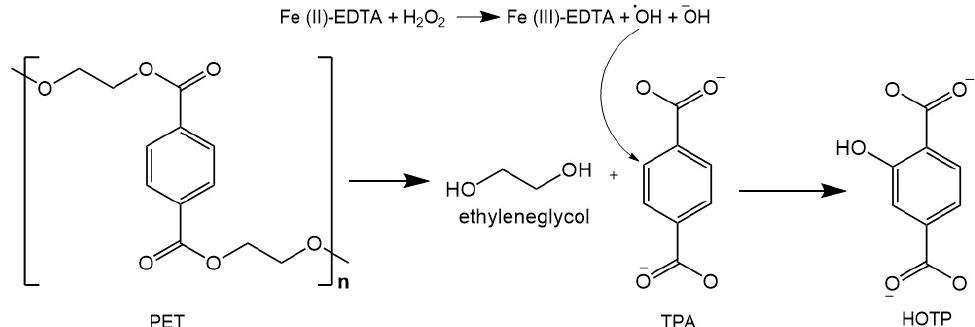
Figure 1. Conversion reaction of terephthalic acid (PTA) into 2-hidroxyterephthalate (HOTP). Note. Reagents added: 30 µ L 2% H 2 O 2 ; 20 µ L 2mM EDTA; and 20 µ L Fe 2 SO 4 · 7H 2 O 3 mM. Adapted from Chaves et al. [30].